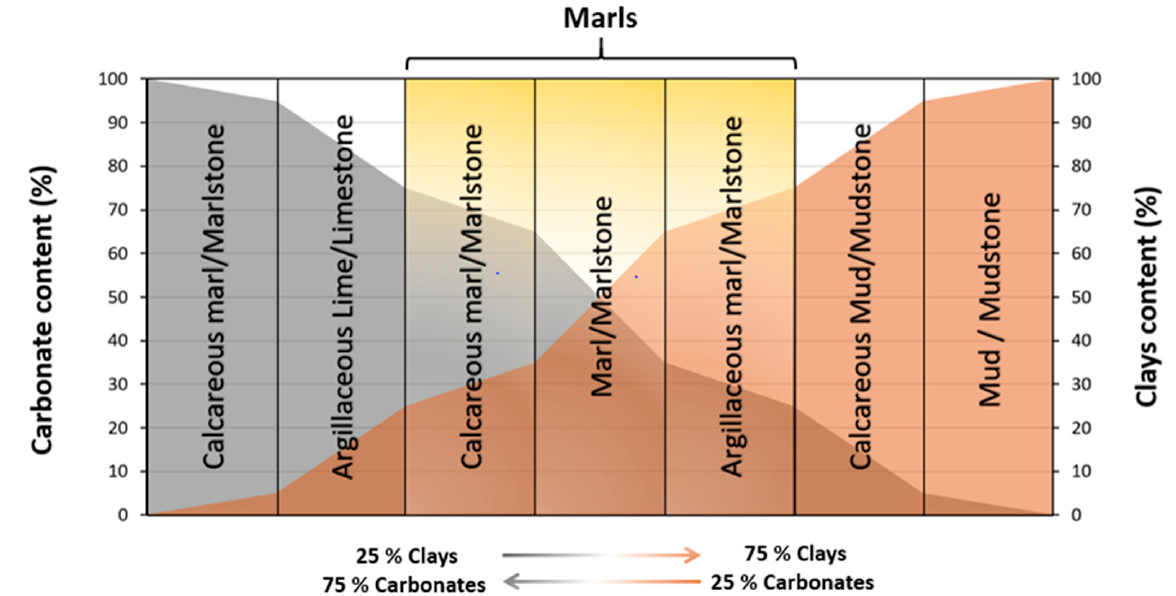
Figure 1. C onventional marls classification.